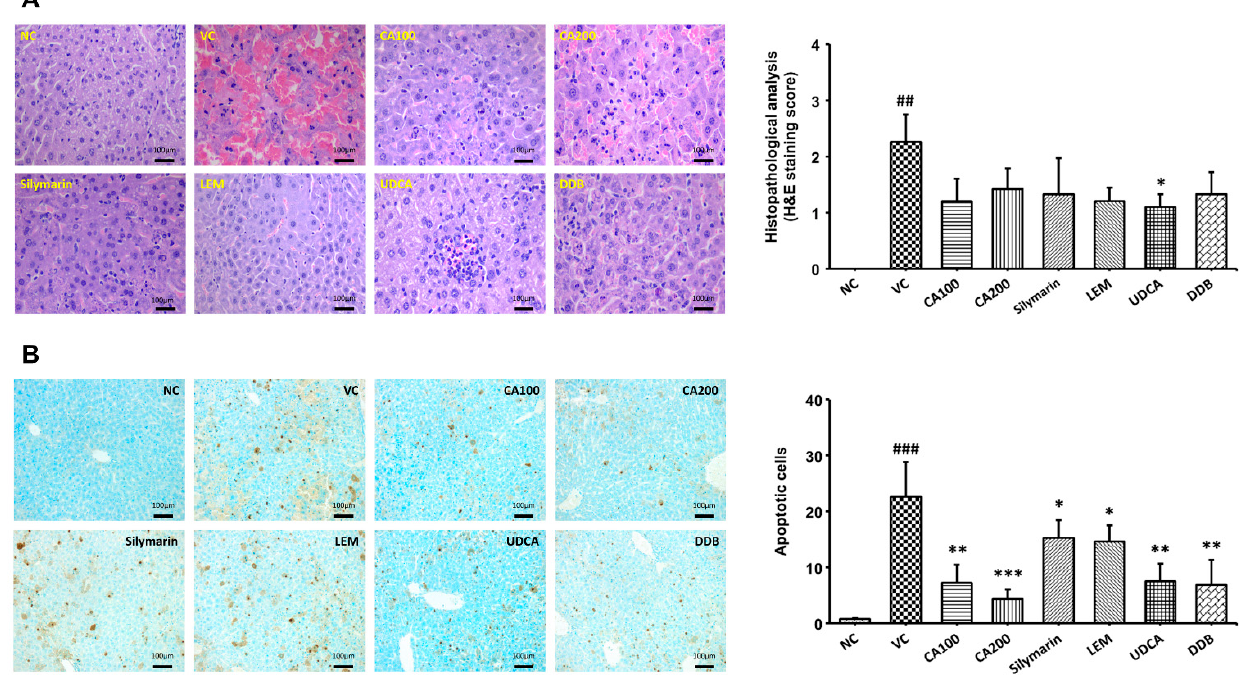
Figure 5. Effect of CA-HE50 on histopathological changes in LPS/D-Gal-induced ALF animal model. Histopathological changes in the extracted liver tissue were confirmed by H&E and TUNEL analysis. Histopathological changes in liver tissue were quantified by lesion scores according to the severity of the lesion. ( A ) Representative images of each group in the histopathological lesion. Histopathological lesion scores are presented as a bar diagram. ( B ) Representative images of each group in apoptotic dead cells by TUNEL analysis. The numbers of apoptotic dead cells are presented as a bar diagram. NC, normal control; VC, vehicle control; CA100, 100 mg/kg CA-HE50; CA200, 200 mg/kg CA-HE50; Silymarin, 100 mg/kg silymarin; LEM, 200 mg/kg LEM; UDCA, 25 mg/kg UDCA; DDB, 200 mg/kg DDB. Data are represented as mean ± SD ( ## p < 0.01 or ### p < 0.001 vs. normal control; * p < 0.05, ** p < 0.01 or *** p < 0.001 vs. vehicle control).